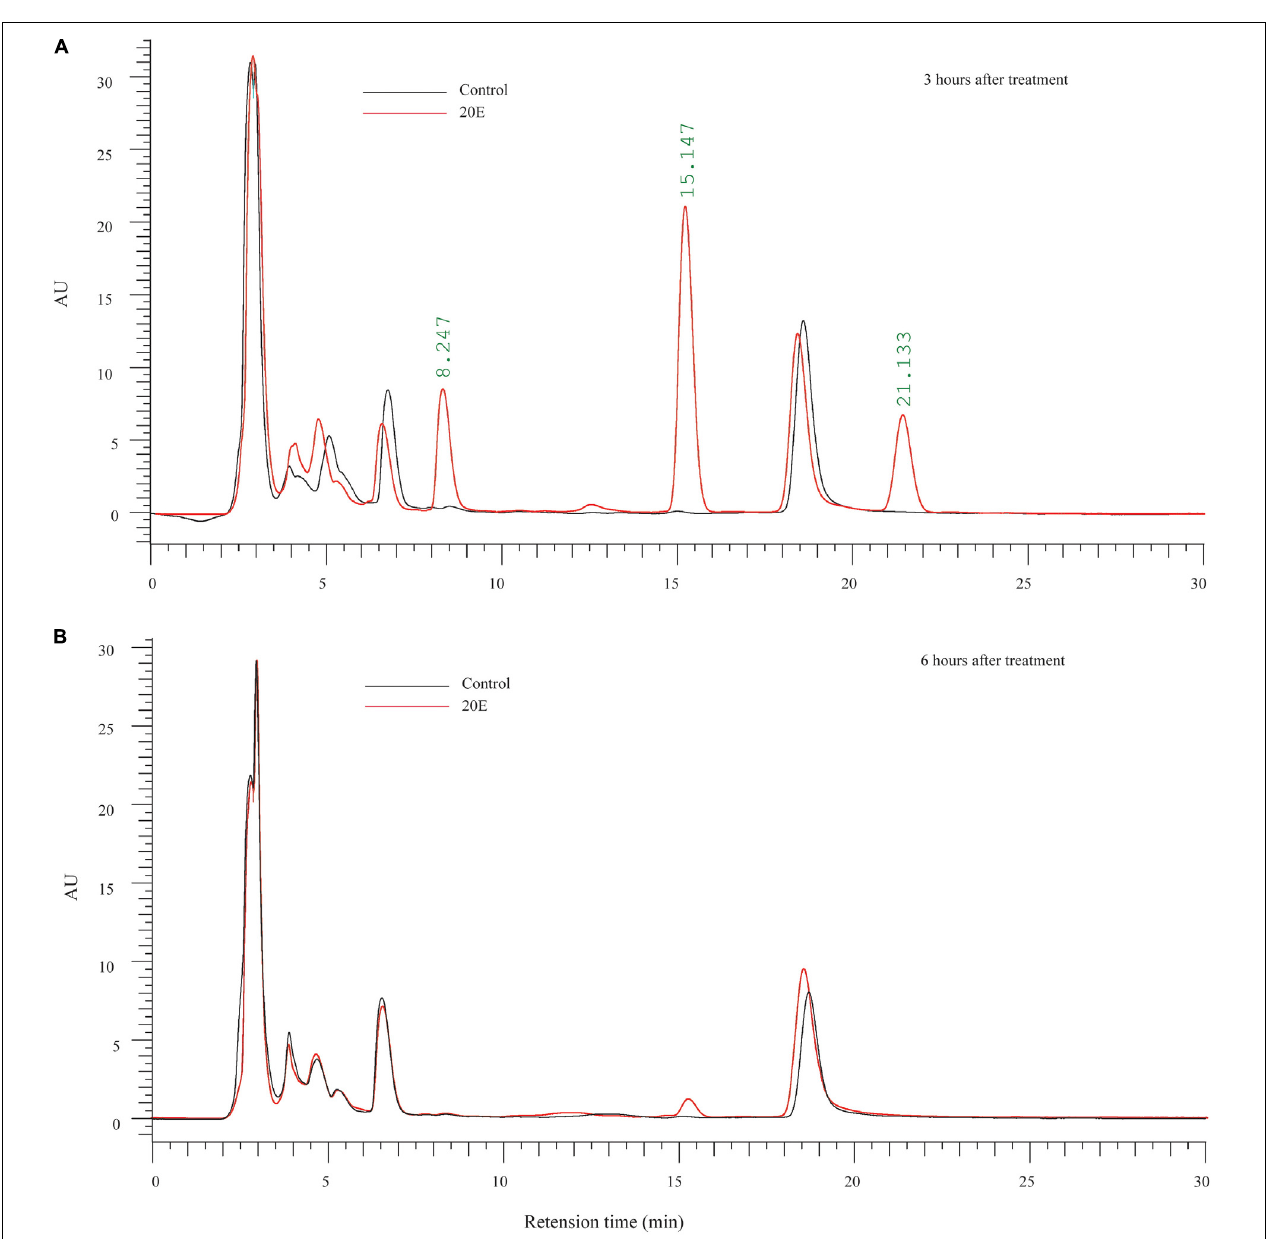
FIGURE 2 | Metabolic fate of ingested 20E. (A) HPLC analysis of ecdysteroids extracted from the feces of larvae at 3 h after control or 20E treatment. (B) HPLC analysis of ecdysteroids extracted from the feces of larvae at 6 h after control or 20E treatment. Black lines represent the extraction from control treated larvae, and red lines represent the extraction from 20E treated